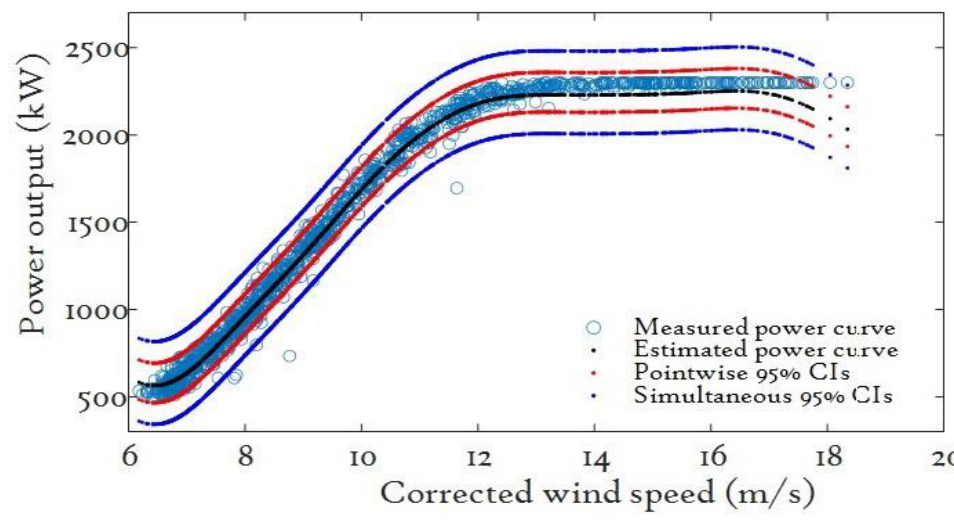
Figure 11. SVM-based power curve comparative investigation.